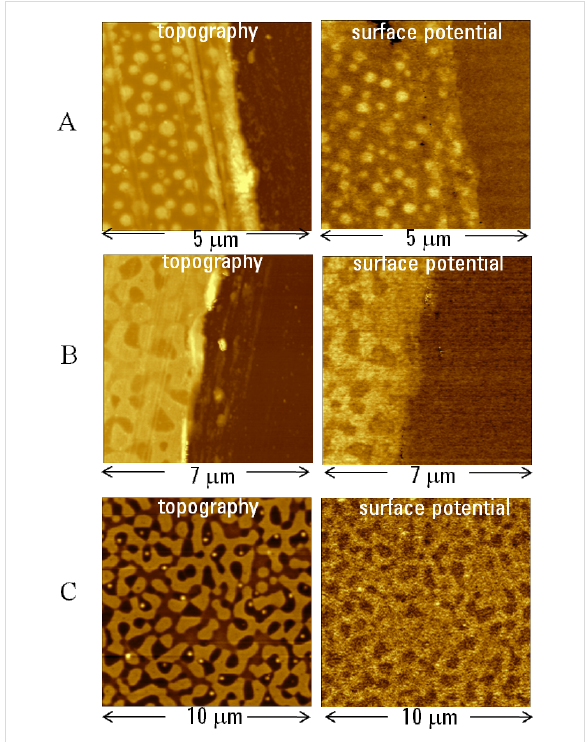
Figure 8: Topography and surface potential images of films of PS/ PMMA blends on a Si substrate. The images in A and B were obtained in air on a scratch location in 70% PS–30% PMMA and 30% PS–70% PMMA blends, respectively. The images in C were obtained on surface of 30% PS–70% PMMA blend in humid air (RH = 95%) after the sample had spent two days in this environment. The contrast covers the height corrugations in the 0–55 nm, 0–75 nm and 0–20 nm ranges in the topography images in A – C and the potential variations in